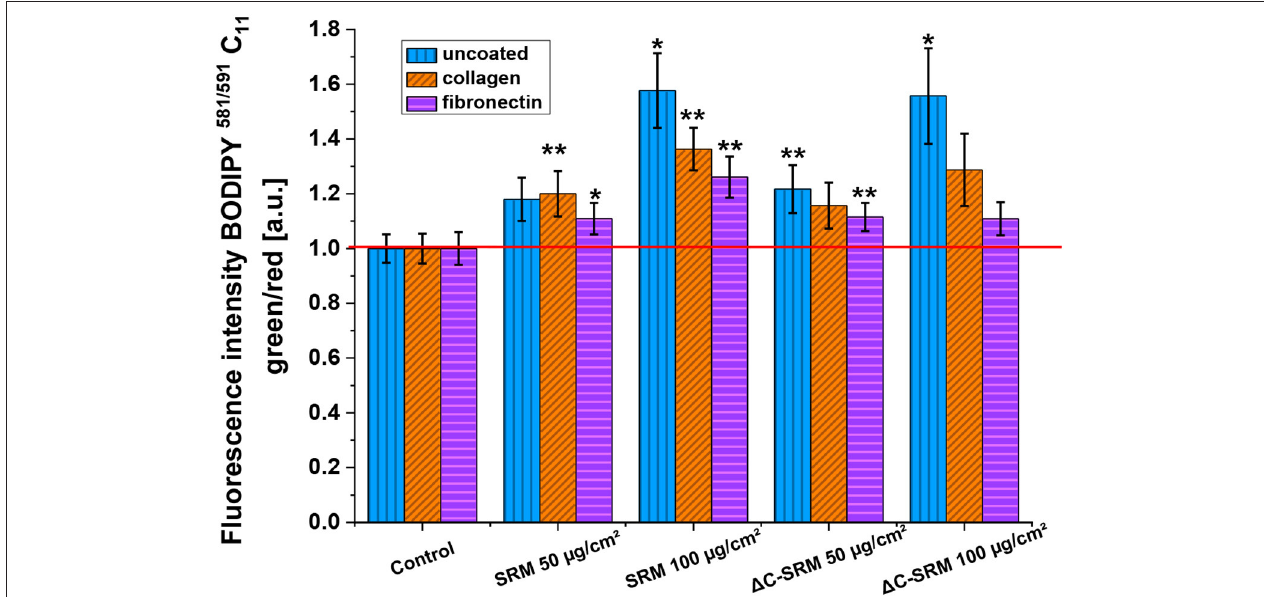
FIGURE 5 | The lipid peroxidation in A549 cells after 24-h incubation with different concentrations of particulate matter (PM)-covered plates either uncoated or coated with fibronectin/collagen measured using C 11 -BODIPY 581 / 591 probe (exposure method 2), * p < 0.05, ** p <